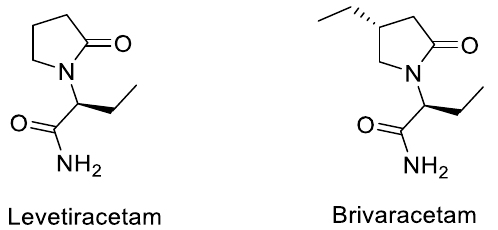
Figure 1. Two antiepileptic drugs: Levetiracetam and Brivaracetam.